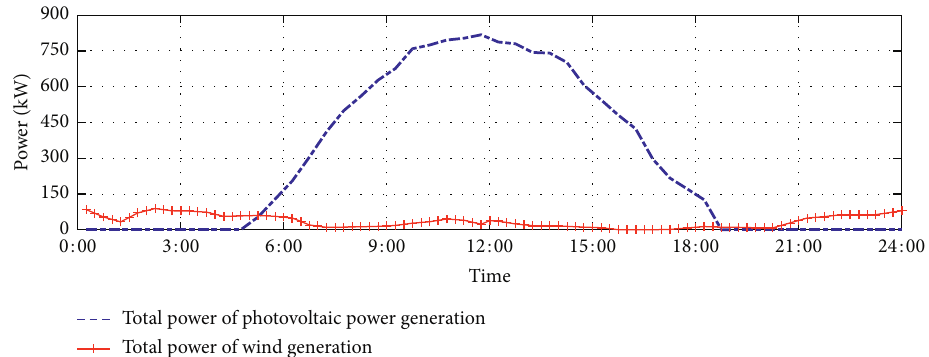
Figure 17: The total power of the wind turbine and photovoltaic power generation of the constant temperature small high-rise building in number 1 residential area. Table 2: Maintenance cost table for wind turbine and photovoltaic power generation.